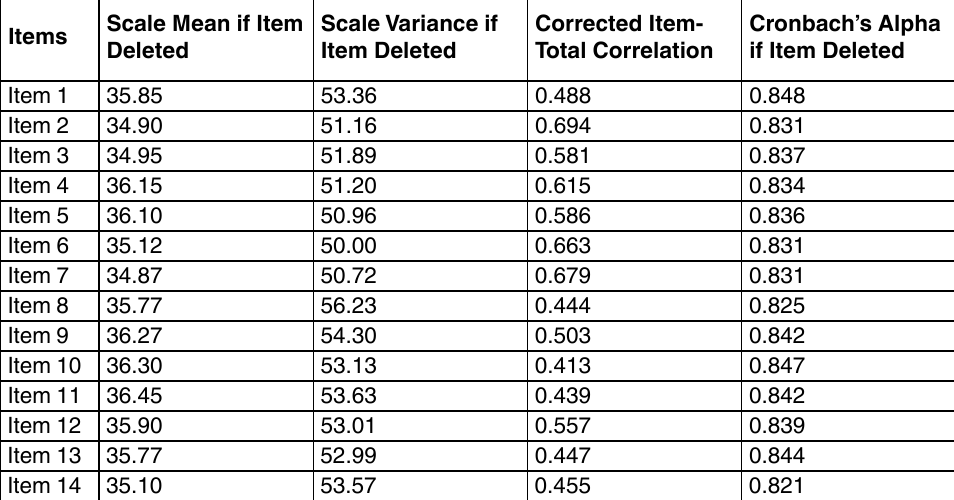
table 3 . Cronbach’s alpha test results for internal consistency of